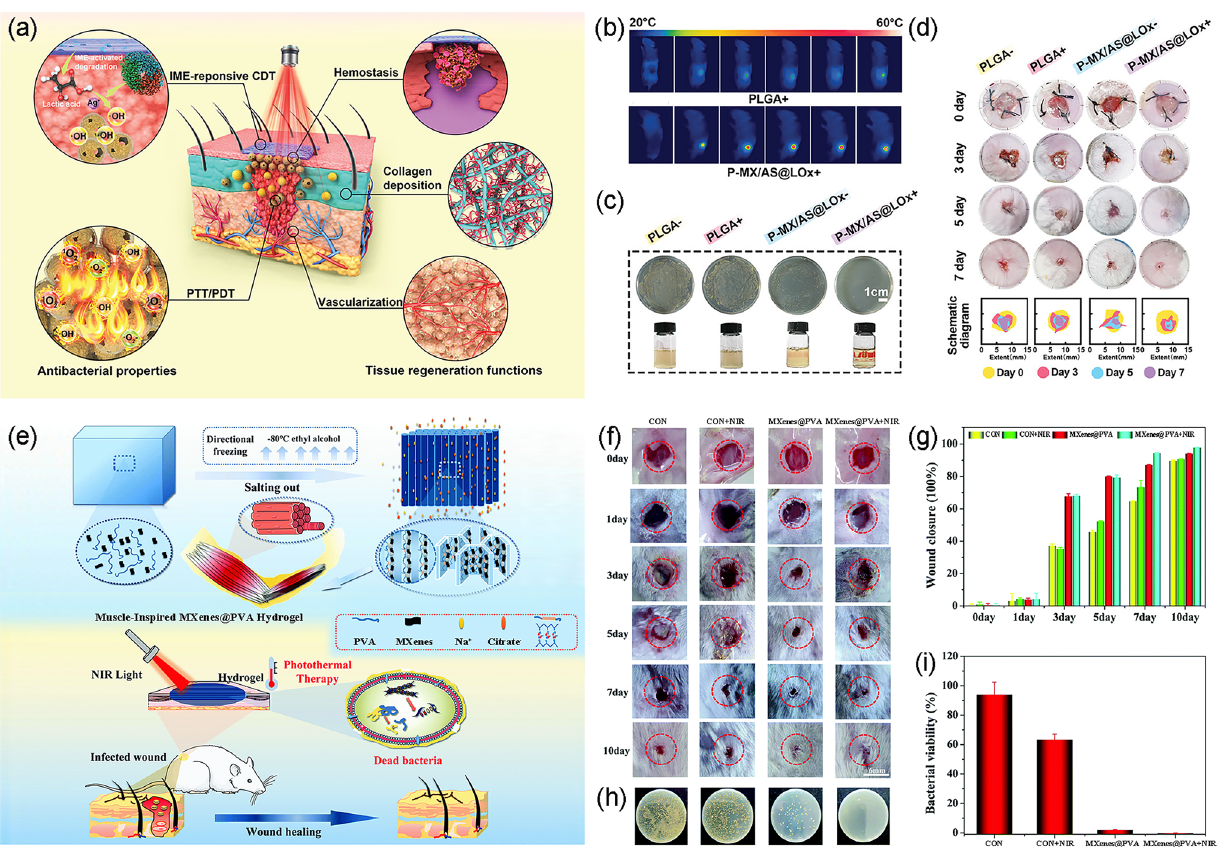
Fig. 11 a Schematic illustration of the antimicrobial and infected wound repair effects by nanocatalytic membrane; b Surface NIR images of membranes under NIR light irradiation for 10 min; c Colony-forming units images of the bacterial colonies after different treatments; d Photo- graphs of S. aureus -infected wounds healing after treatments [22]. Copyright 2021, Wiley–VCH. e Schematic illustration of the antimicrobial and infected wound repair effects by MXenes@PVA hydrogel; f Photographs of healing of S. aureus -infected wounds in different treatment groups; g Wound contraction evaluations of healing of S. aureus -infected wounds in different treatment groups; h Colony-forming units images of the bacterial colonies different treatments; i Quantitative bacterial viability based on h [148]. Copyright 2022, Royal Society of